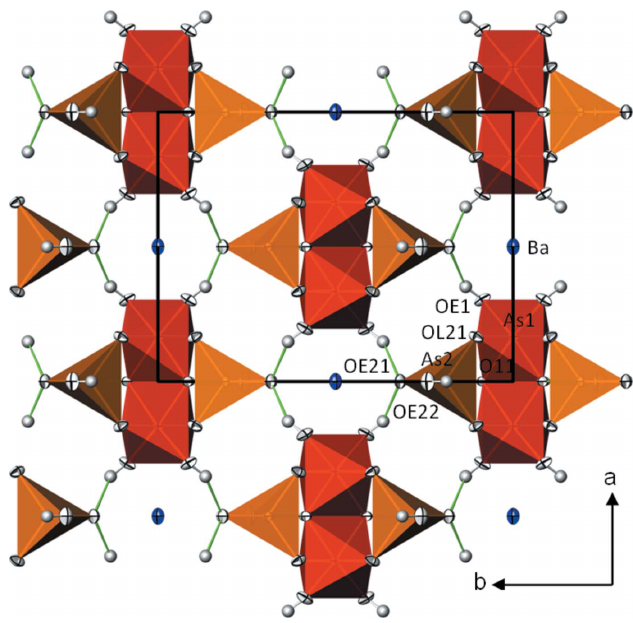
Figure 1 The crystal structure of BaH 6 As 4 O 14 in a projection along [001]. Displacement ellipsoids are drawn at the 97% probability level. [AsO 4 ] tetrahedra are orange, [AsO 6 ] octahedra are red, and O—H (cid:2)(cid:2)(cid:2) O hydrogen-bonding interactions are shown as green lines.